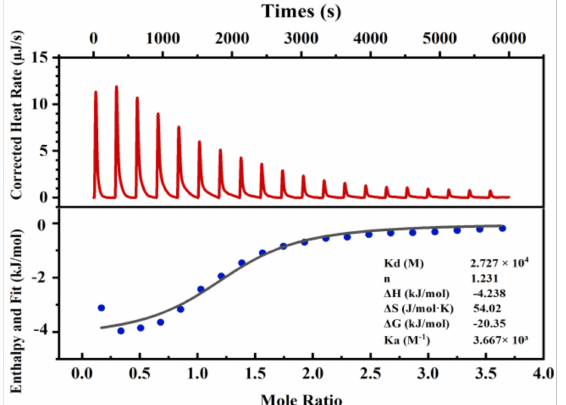
Figure 2. ITC analyses of the CBP-H peptide reacting with calcium ions. The upper panel exhibited a representative calorimetric titration curve. CaCl 2 (50 mM) was titrated into 2.5 mM of the peptide solution at 25 ◦ C. The lower panel shows the integrated areas corresponding to each titration, plotted as a function of the Ca 2+ /peptide molar ratio. The solid line represents the best curve fit obtained by using an independent binding site